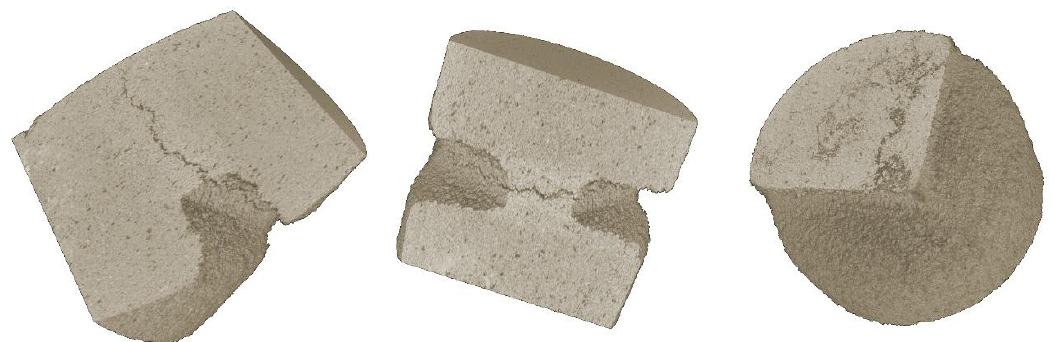
Figure 7. The visualisation of the crack in the last damage state (CT4) of a wet specimen.